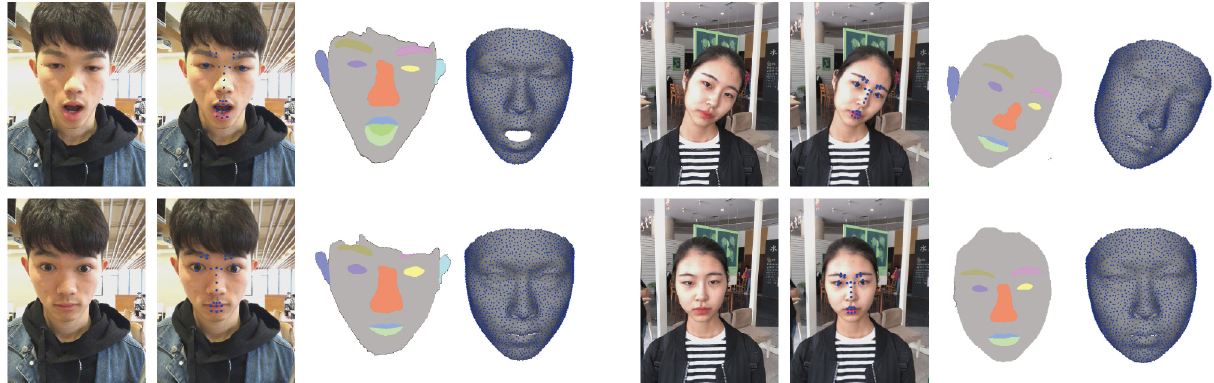
Fig. 3 Two examples of FaceFlowData, with (left) expression change and (right) significant pose change. For each example, left to right: the raw RGB image, 34 facial landmarks, human face parsing result, and reconstructed 3D face with 2009 sampled